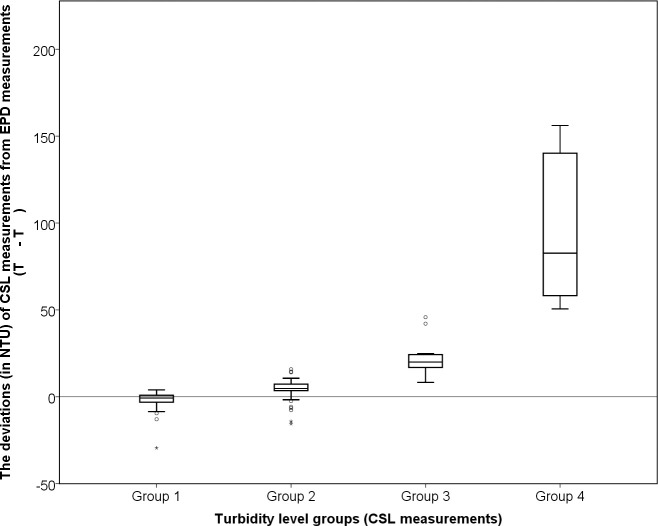
A box plot showing the deviation between the CSL-measured turbidity level (TCSL) and the EPD-measured turbidity level (TEPD) on all the paired monitoring sites with less than 100 m separated distances.Each interval group contains the actual CSL measurements within a specific turbidity range: Group 1—Turbidity ≦5.5 NTU; Group 2–5.5 NTU < Turbidity ≦20.5 NTU; Group 3–20.5 NTU < Turbidity ≦50.5 NTU; Group 4–50.5 NTU < Turbidity.